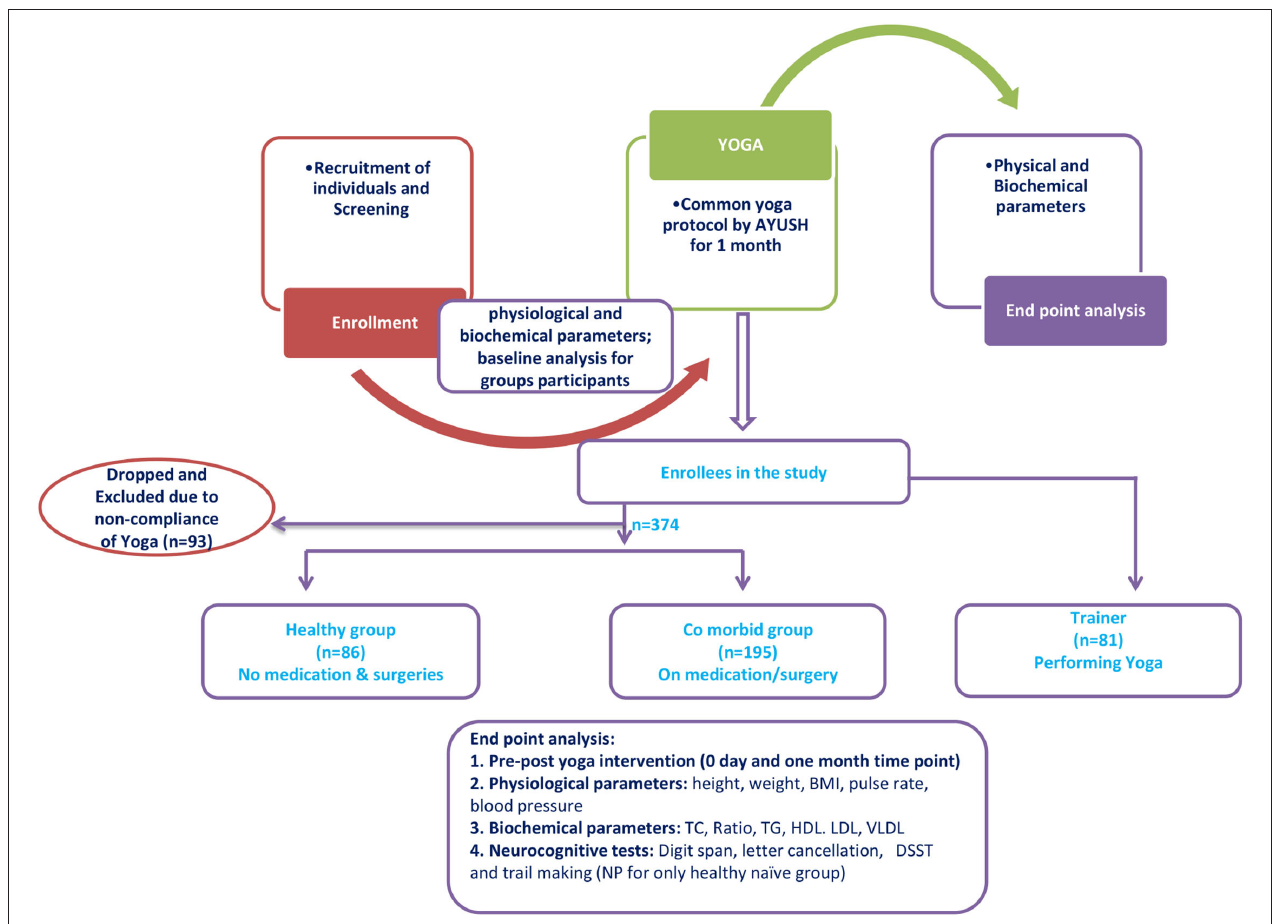
FIGURE 1 | Plan of the study in a flowchart